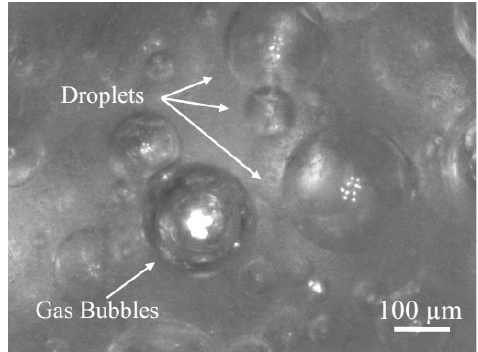
Figure 3. The distinction between gas bubbles and droplets.